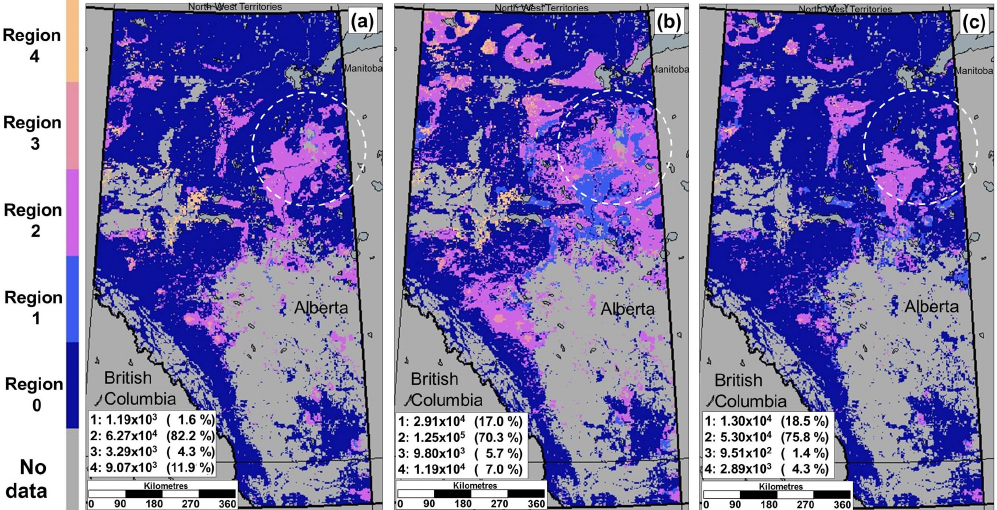
Figure 16. Predicted sub-types of terrestrial ecosystem critical load exceedance (see Fig. 2), with panels arranged as in Fig. 15. Inset information shows the area within S + N exceedance sub-types 1, 2, 3, and 4 (km 2 ) and the corresponding percentage of the total area of exceedance. Circled region: 140km radius diameter circle around the Athabasca oil